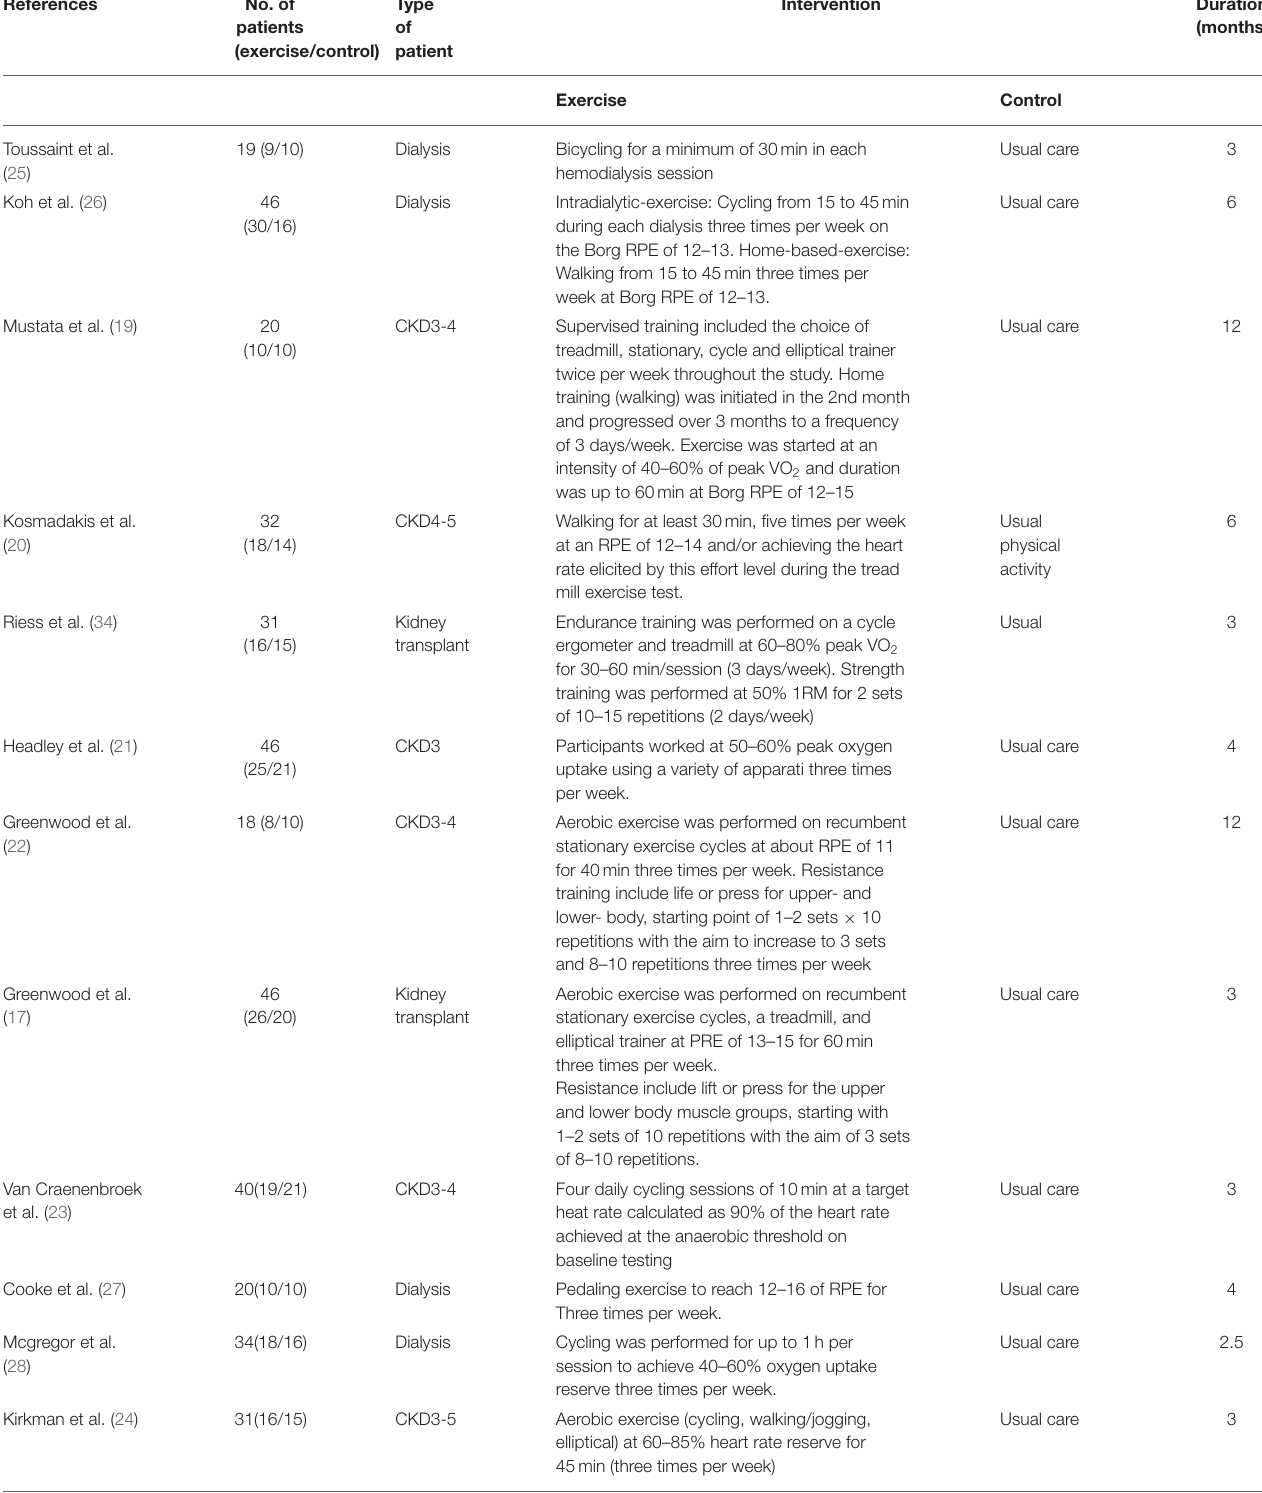
TABLE 1 | Basic characteristics of subjects and treatments of trials.